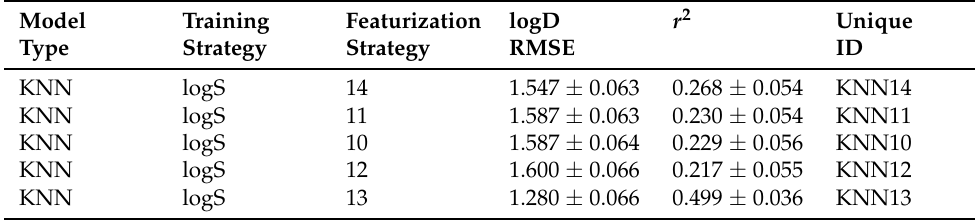
Table A15. Shows the logS RMSE and r 2 results for the non-GNN model types used during this survey. The last column consists of the unique identifier. Training strategy 0 represents a training strategy combining logD, logS, and logP, 1 represents a strategy combining logD and logP, 2 stands for a combination of logD and logS, 3 represents a strategy using logS and logP, 4 represents a strategy using logD, 5 represents a strategy using logS, and 6 represents a strategy using